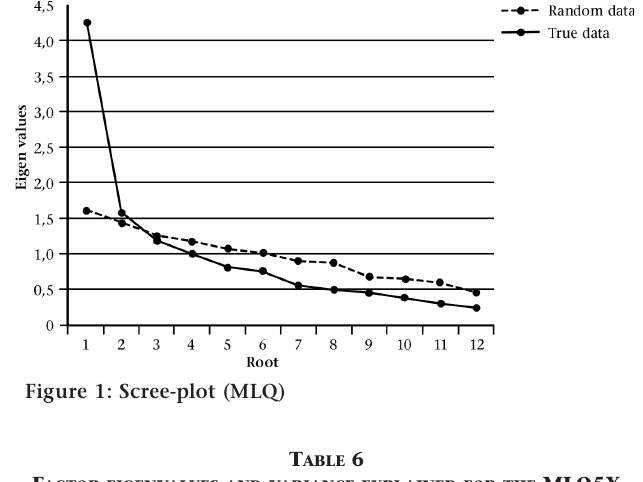
Figure 1: Scree-plot